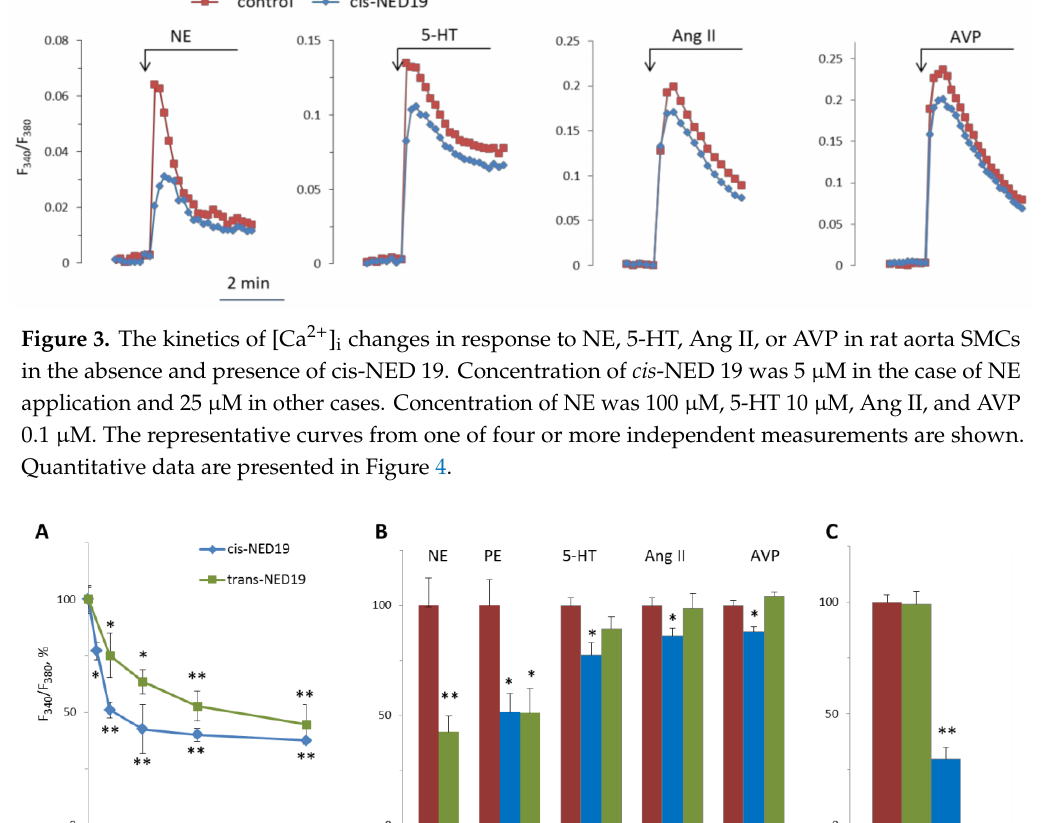
Figure 3. The kinetics of [Ca 2+ ] i changes in response to NE, 5-HT, Ang II, or AVP in rat aorta SMCs in the absence and presence of cis-NED 19. Concentration of cis -NED 19 was 5 μM in the case of NE application and 25 μM in other cases. Concentration of NE was 100 μM, 5-HT 10 μM, Ang II, and AVP 0.1 μM. The representative curves from one of four or more independent measurements are shown. Quantitative data are presented in Figure 4.